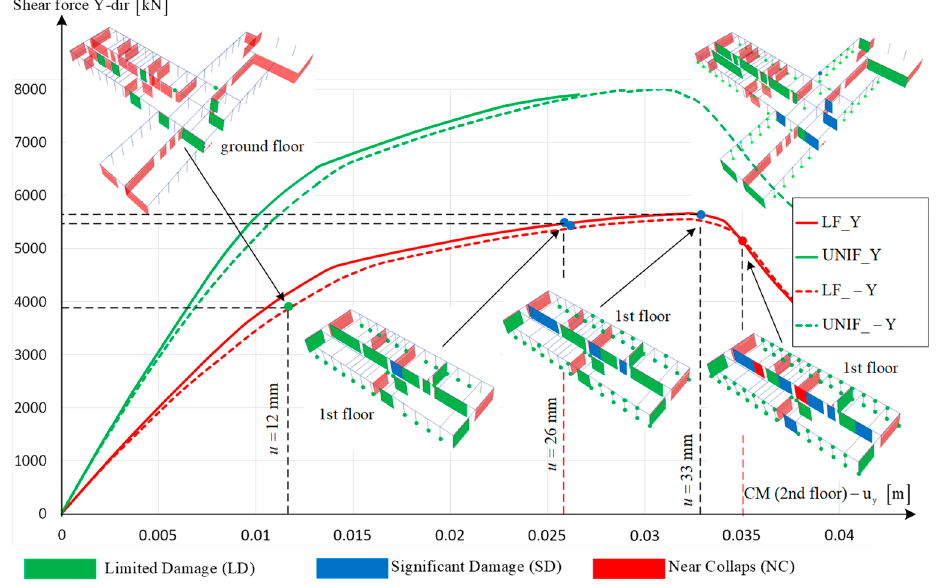
Figure 16. Pushover curves in Y-dir for as-built structure.